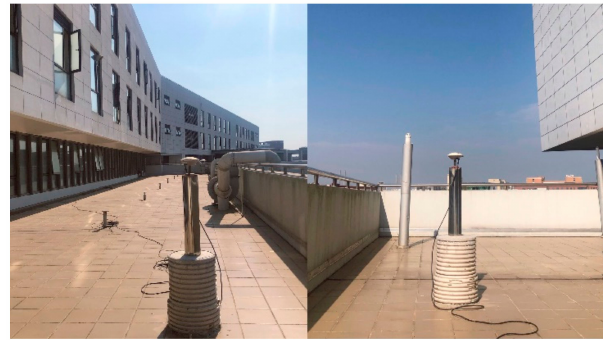
Figure 13. The environment of the rover station of the Ublox test.